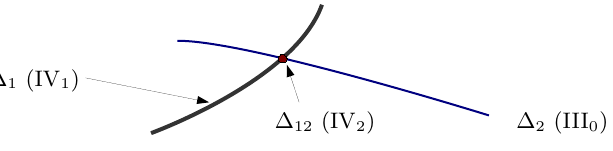
Figure 20 . Two singular divisors (cid:1) 1 and (cid:1) 2 intersect at the large complex structure point (cid:1) 12 , where the corresponding types of degenerations are also labelled. The coloured divisor shows one